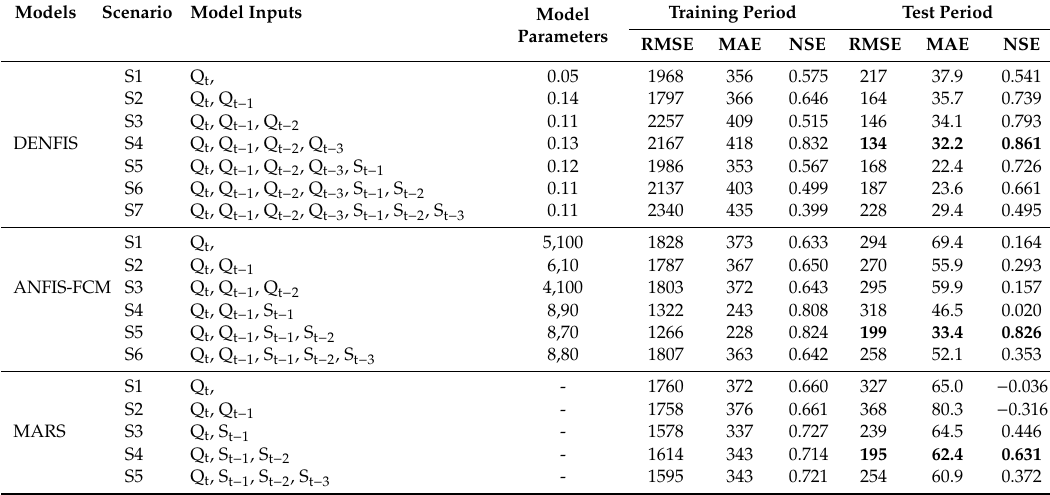
Table 2. The training and test statistics of the DENFIS, ANFIS-FCM and MARS models using di ff erent combinations of sediment and streamflow for daily suspended sediment prediction, Guangyuan